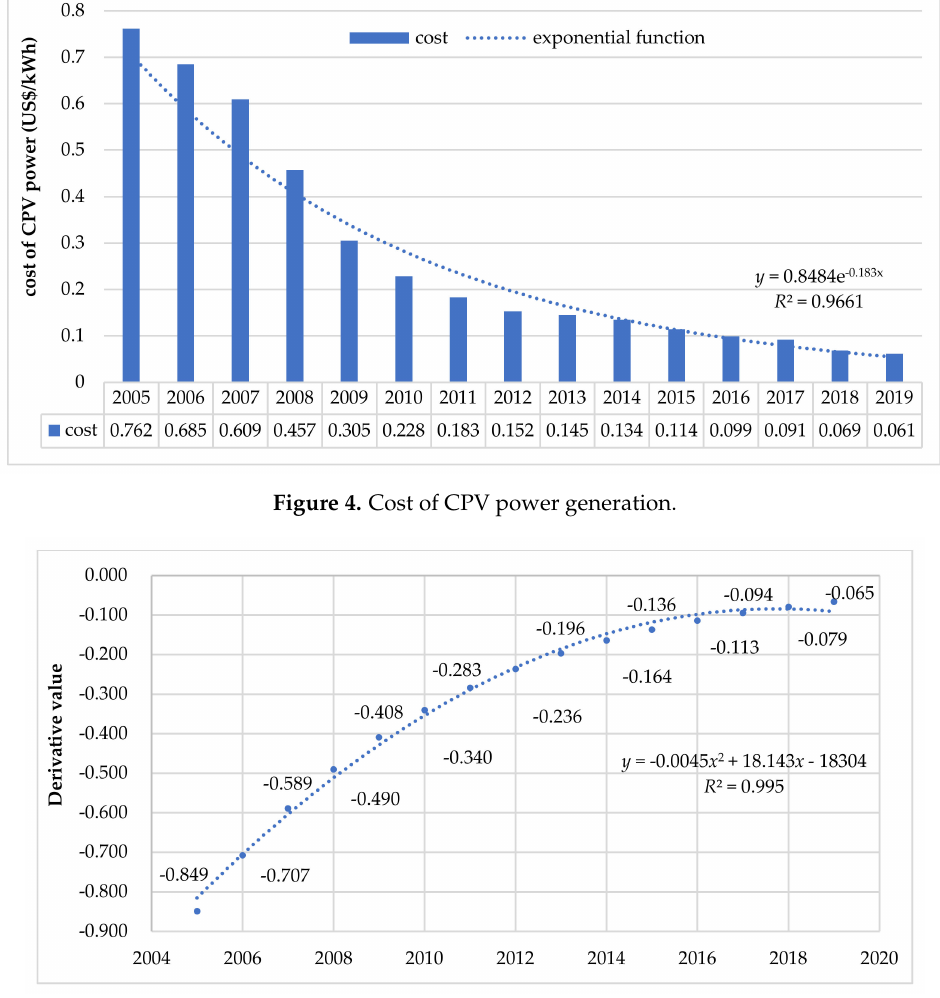
Figure 5. Derivative of CPV cost